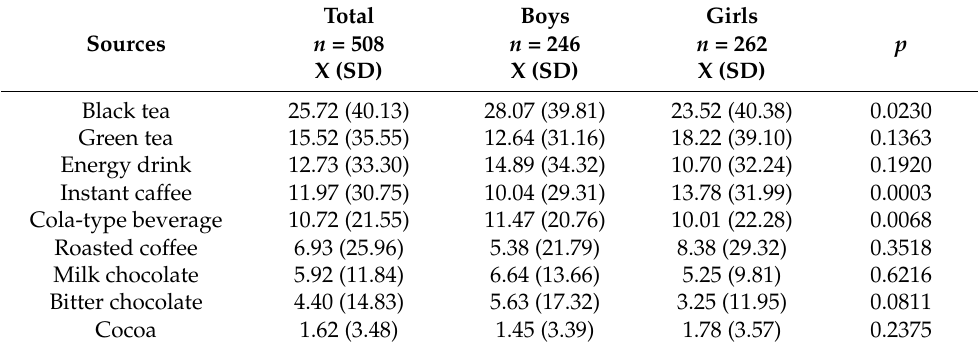
Figure 2. The share of the individual sources of caffeine in the diet of the study group during the day (%). The average caffeine intake was 25.72 ± 40.13 mg for black tea, 15.52 ± 35.55 mg for green tea and 12.73 ± 33.30 mg for energy drinks. As regards gender groups, boys consumed significantly higher doses of caffeine with black tea (28.07 ± 39.81 mg vs. 23.52 ± 40.38 mg; p = 0.0230) and cola-based soft drinks (11.47 ± 20.76 mg vs. 10.01 ± 10.01 mg; p = 0.0068) and girls with instant coffee (10.04 ± 229.31 mg vs. 13.78 ± 31.99 mg; p = 0.0003; Table 3. Average caffeine intake in the gender groups (mg).